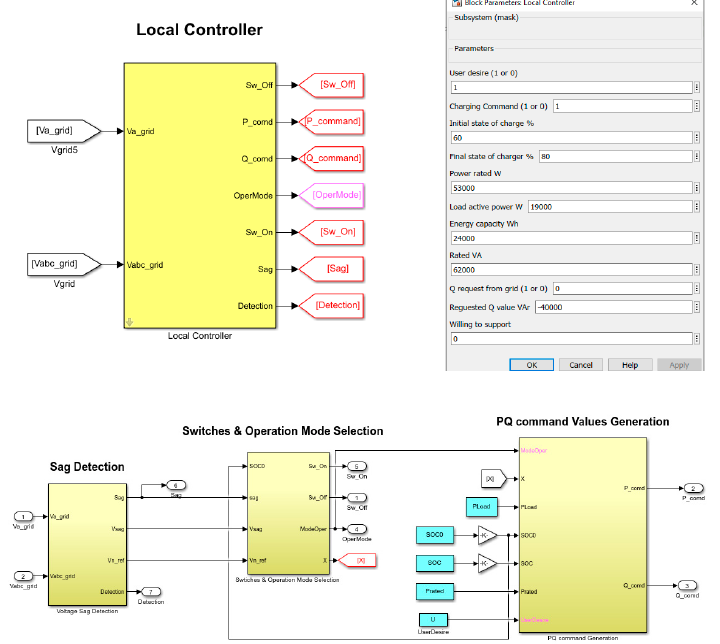
Figure 6. Local controller mask block.